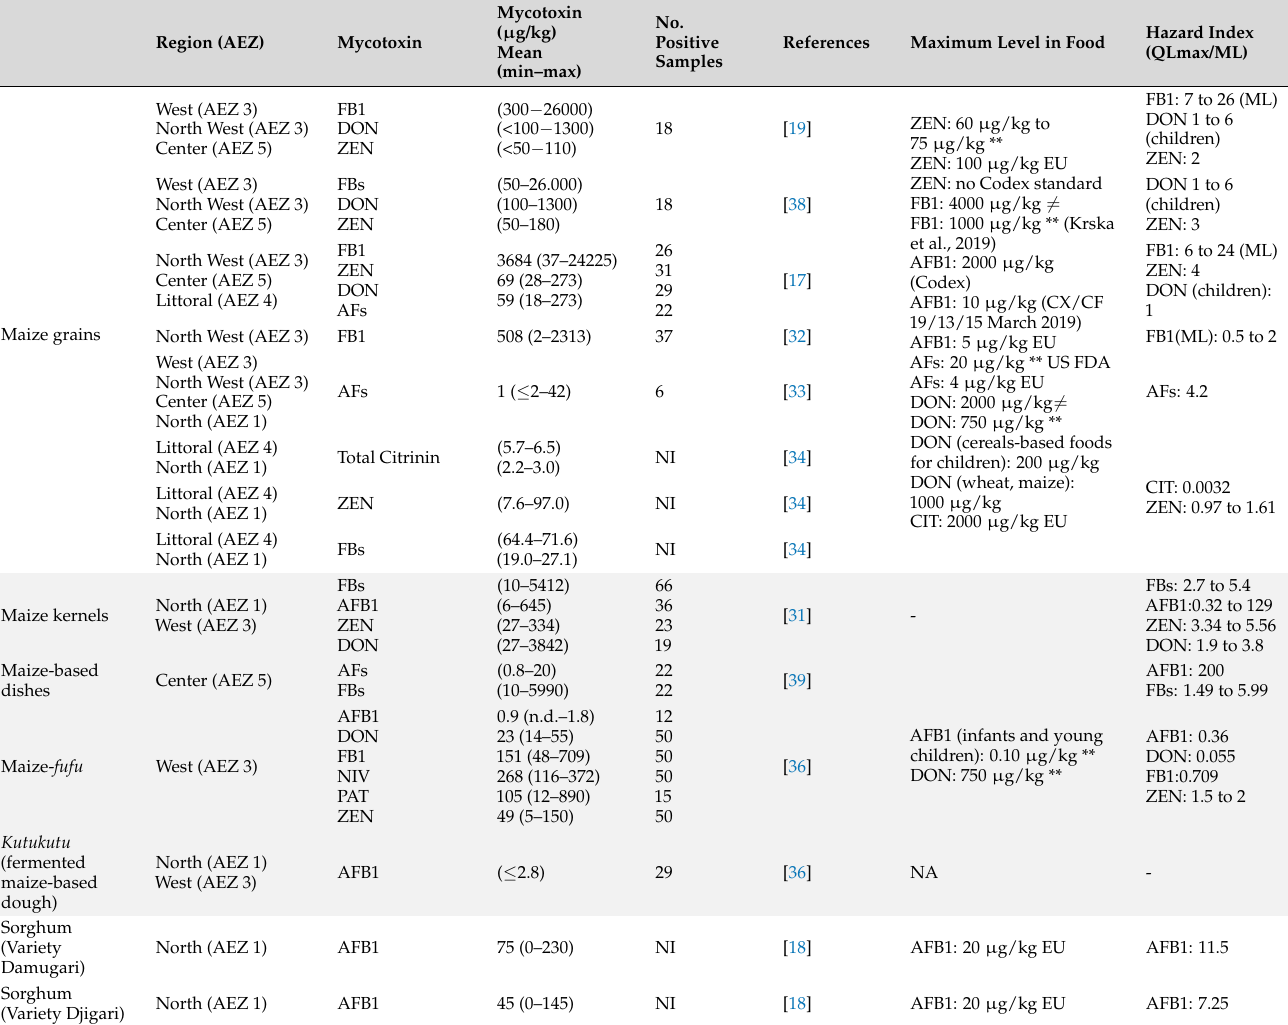
Table 2. Mycotoxins in Cameroonian food and their